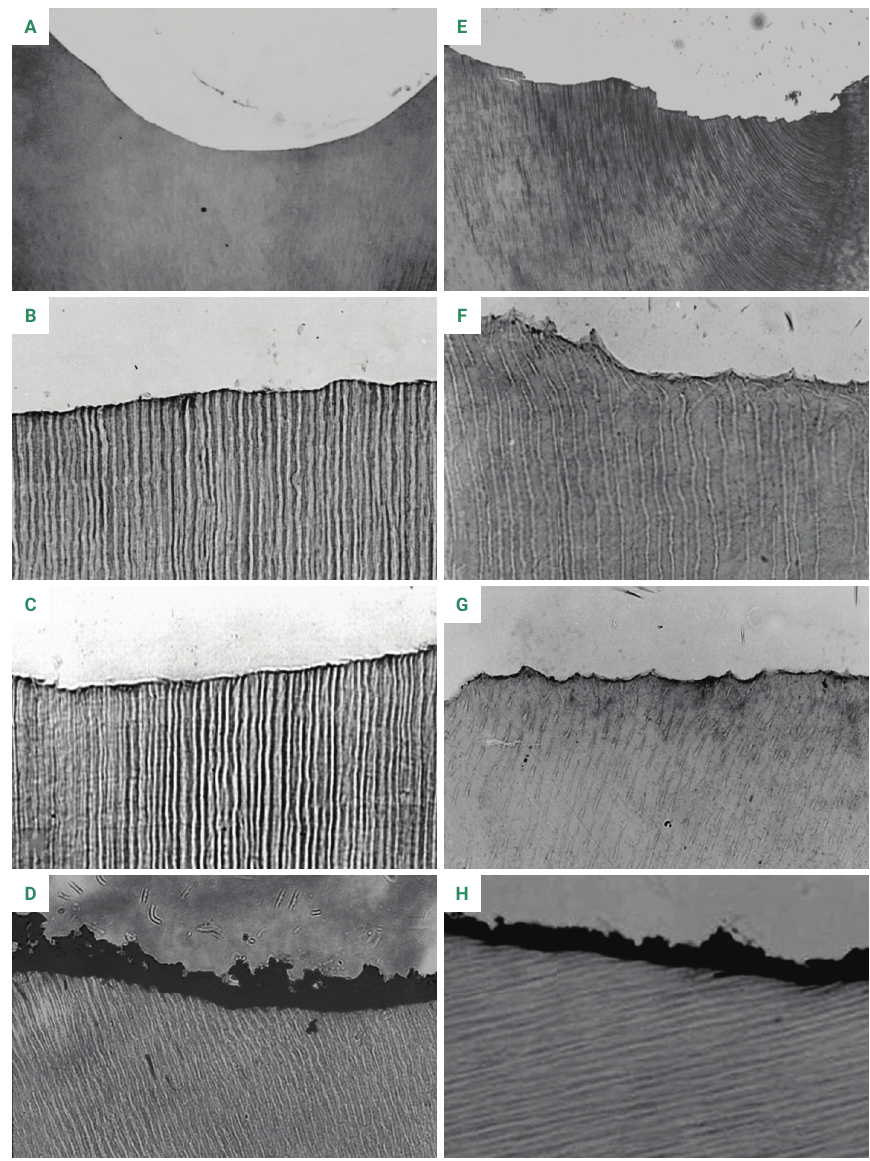
Figure 1. (A) Preparation accomplished with the convention technique in Group GI – Regular dentin surface obtained by the spherical drill (Microscopy 200X). (E) Preparation accomplished with the ART technique in Group GI – Irregular dentin surface obtained by the instruments used in the ART technique (Microscopy 200X). Dentin adhesive surface using the glass ionomer KETAC FILL, VIDRION R and FUJI II LC after carious tissue removal by the conventional technique in B, C and D, respectively (Microscopy 400X). Dentin adhesive surface using the glass ionomer KETAC FILL, VIDRION R and FUJI II LC after carious tissue removal by the ART technique in F, G and H (Microscopy